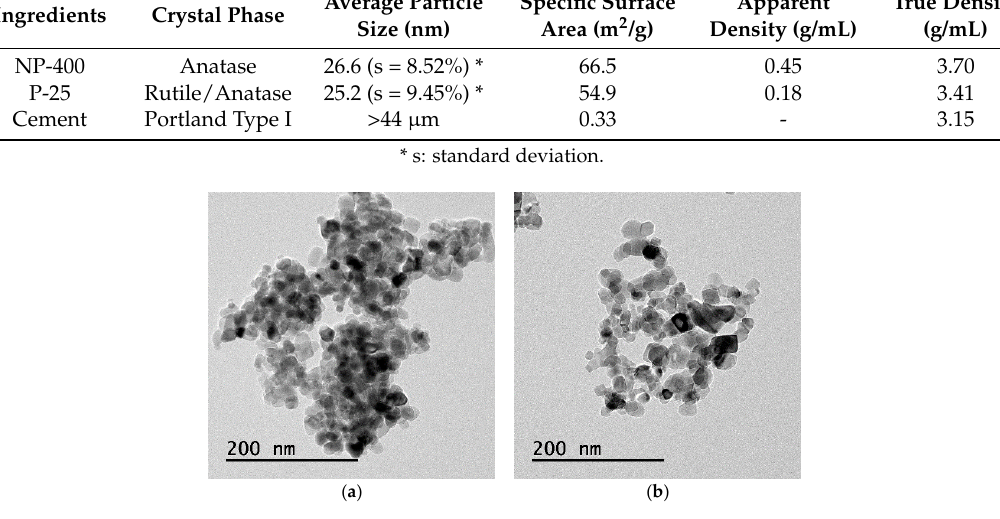
Table 1. TiO 2 preparations mixed with cementitious materials.